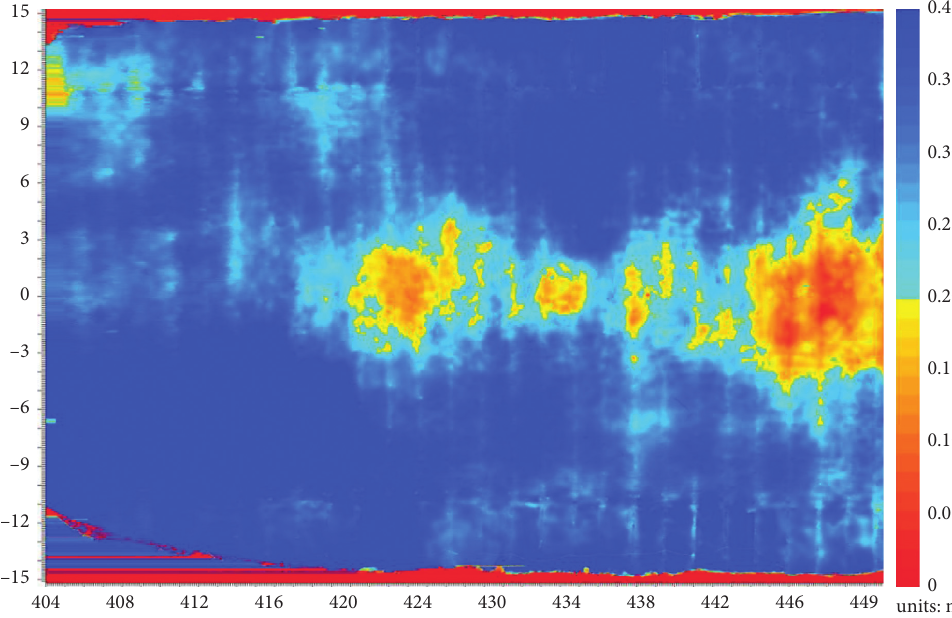
Figure 15: Expanded view of primary support clearances’ scanning cloud